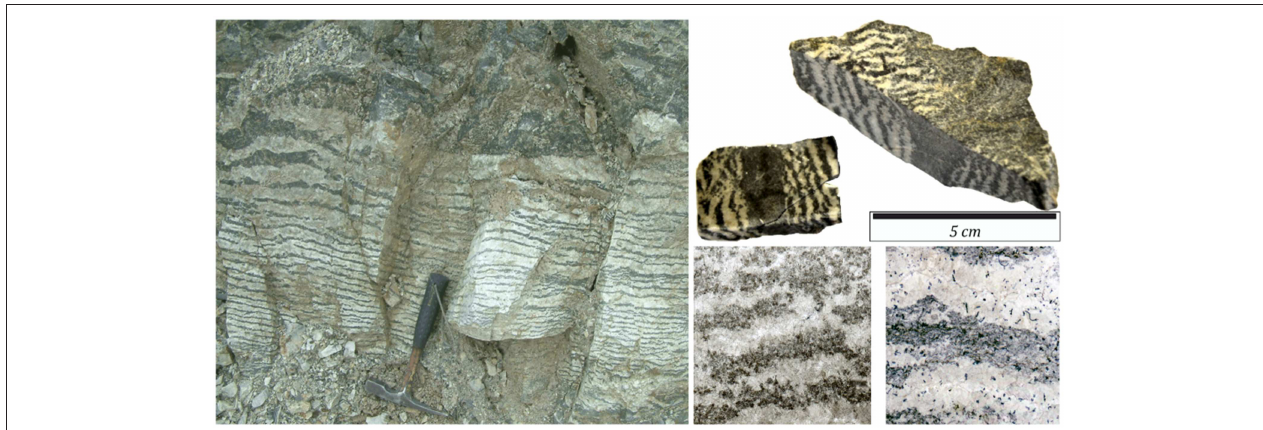
FIGURE 1 | Examples of zebra textures at different scales. The left picture shows an outcrop in the area of the San Vicente mine. On the right side a hand specimen and two thin sections are shown. The area of the displayed thin sections is 1 cm 2 which is equivalent to the area of the simulation. The two micrographs show zebra banding with different spacing between the dark and the light